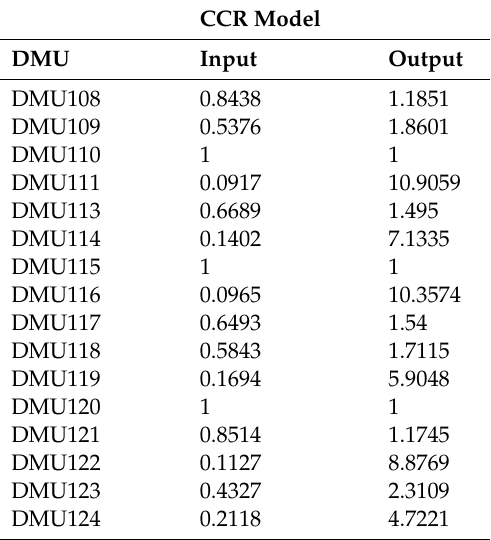
Table 7. CCR method for assessing the e ff ectiveness of metal